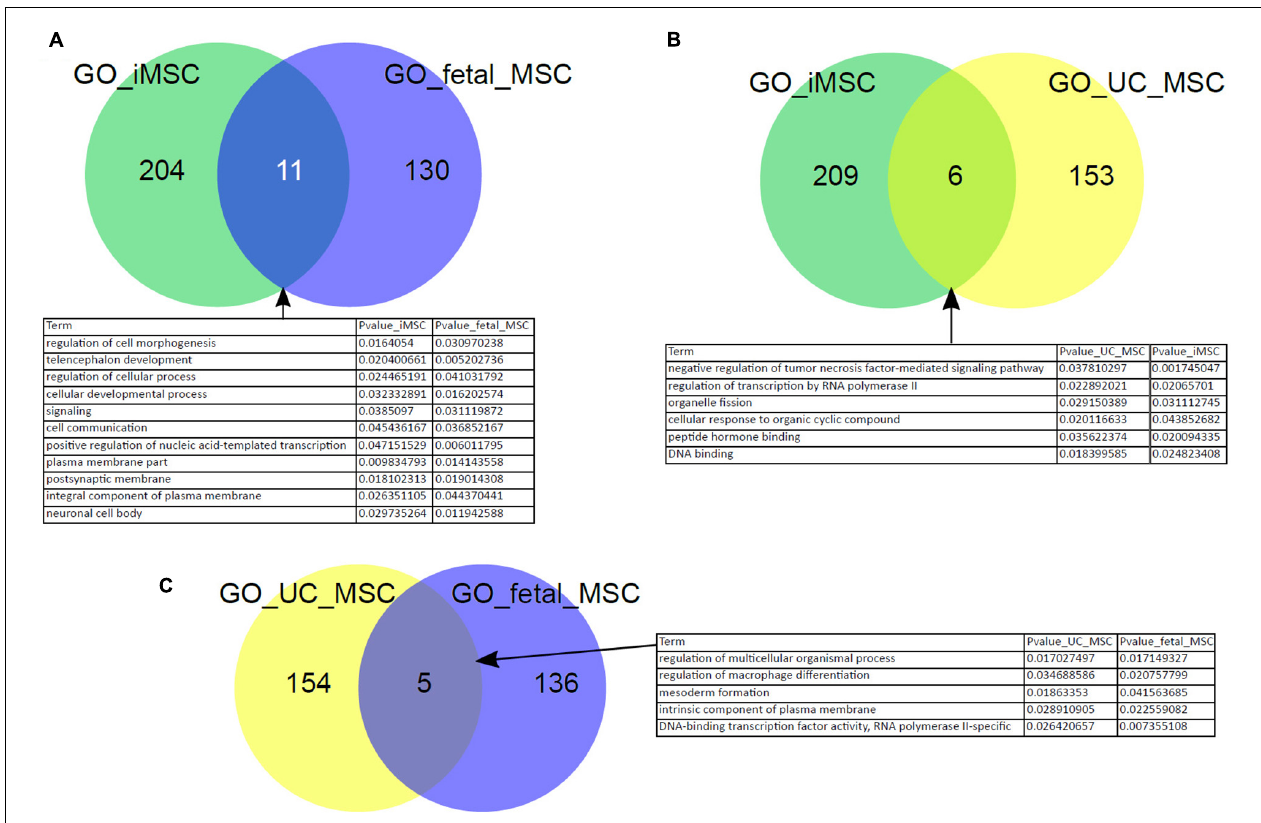
FIGURE 5 | Characteristics of iMSCs overlap with those of MSCs from young origin. Overlapping over-represented GO terms between iMSCs, fetal MSCs, and UC-MSCs were identified. The overlap is connected to developmental processes (A–C)